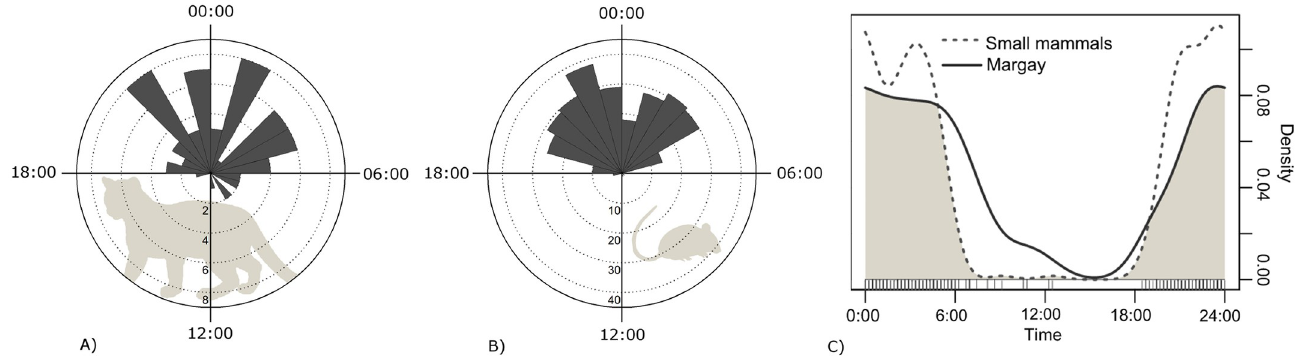
Fig 8. Daily activit y patterns and temporal overlap of margay and small mammals for the sampled region as whole. A) margay, B) small mammals, C) temporal overlap of margay and small